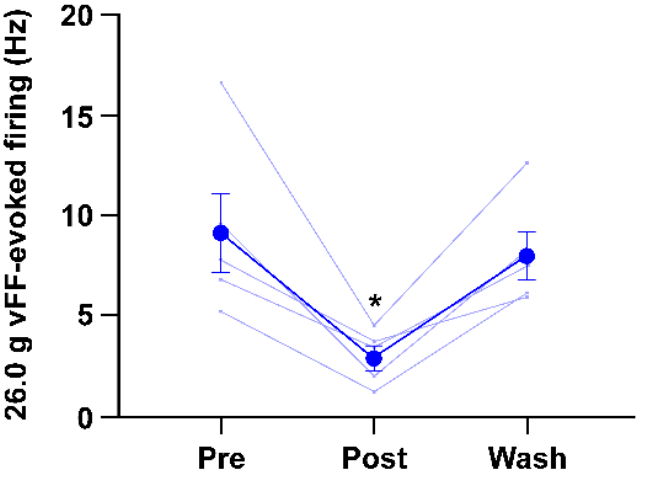
Figure 4. Administration of 0.5% lidocaine to the vFF stimulation site significantly inhibited the 26.0 g vFF-evoked firing frequency. After the wash, the firing frequency returned to the initial level. The data are presented as the means ± SEM; * p < 0.05 vs. Pre using Dunnett’s multiple comparison test ( n = 5); vFF, von Frey filaments; SEM, standard error of the mean.